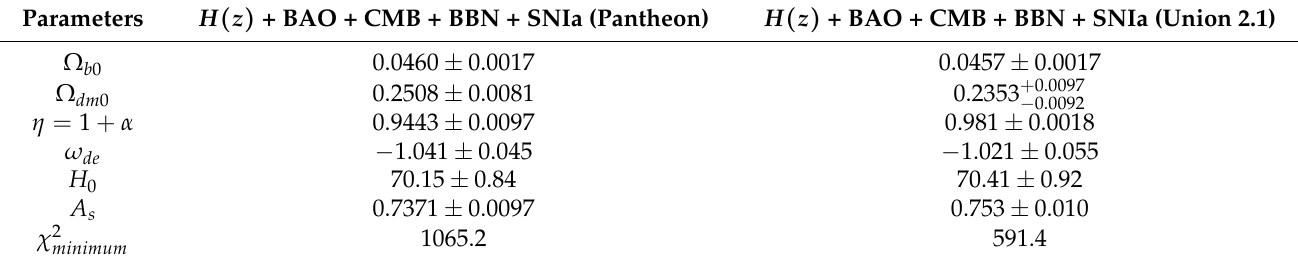
Table 1. Results of statistical likelihood analysis (minimum of χ 2 ) obtained in [37] by using a different combination of observational datasets such as ( H ( z ) + BAO + CMB + BBN + SNIa (Pantheon)) and ( H ( z ) + BAO + CMB + BBN + SNIa (Union 2.1)), for the present model (for more details, one can look into Table 3 of [37]).